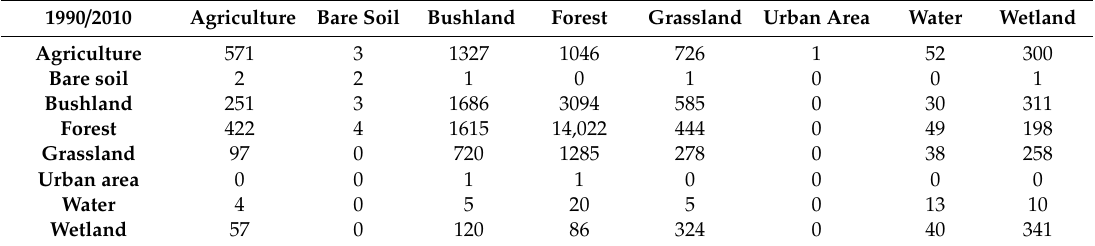
Table 5. Transition matrix of the land use in the Kilombero Valley floodplain from 1990 to 2010 (km 2 ). 1990 / 2010 Agriculture Bare Soil Bushland Forest Grassland Urban Area Water Wetland Agriculture